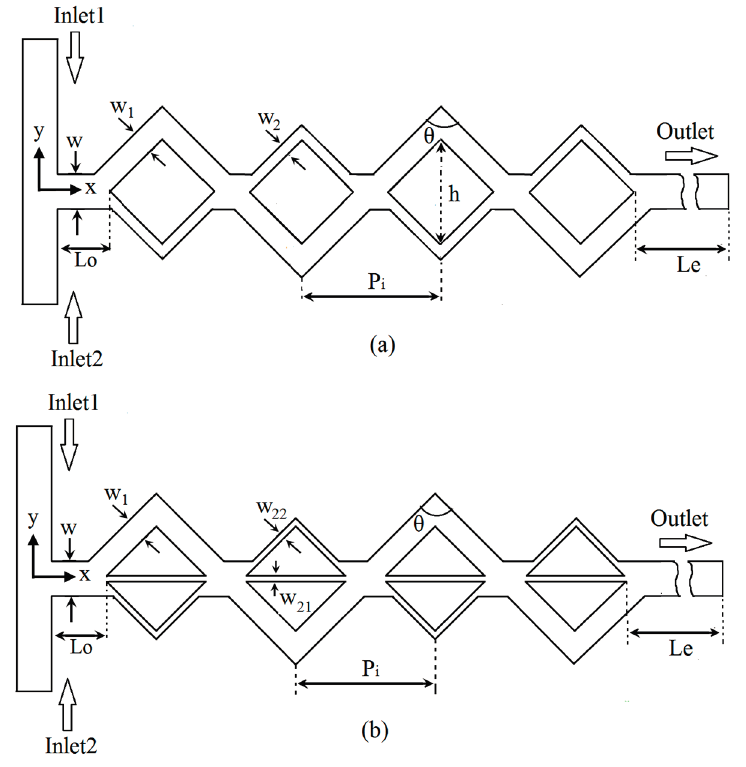
Figure 1. Schematic diagrams of rhombic micromixers: ( a ) unbalanced two-split rhombic micromixer, and ( b ) unbalanced three-split rhombic